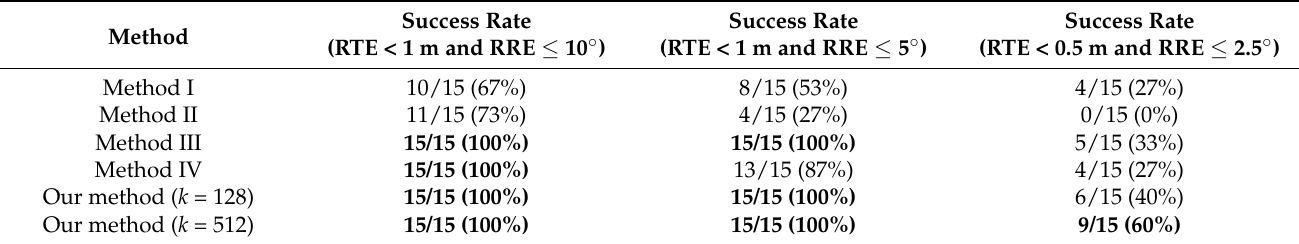
Table 2. The registration success rates of different methods in Dataset